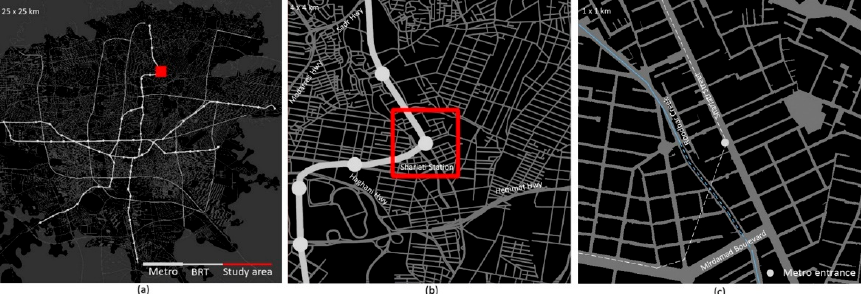
Figure 1. The North: Shariati station area. 25 km × 25 km ( a ), 4 km × 4 km ( b ), and 1 km × 1 km ( c ). Maps: Nastaran Peimani.